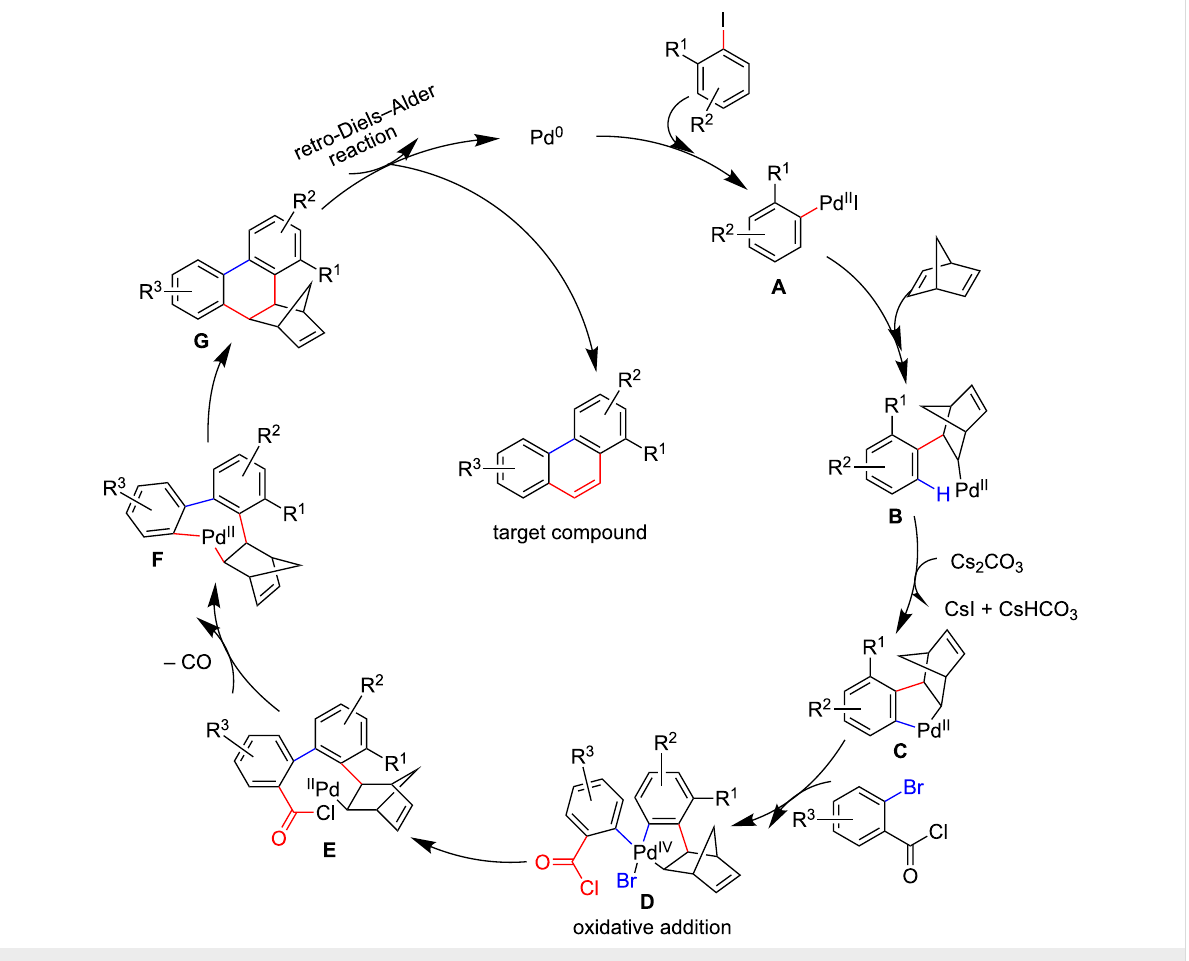
Scheme 5: Proposed mechanism for the formation of phenanthrene